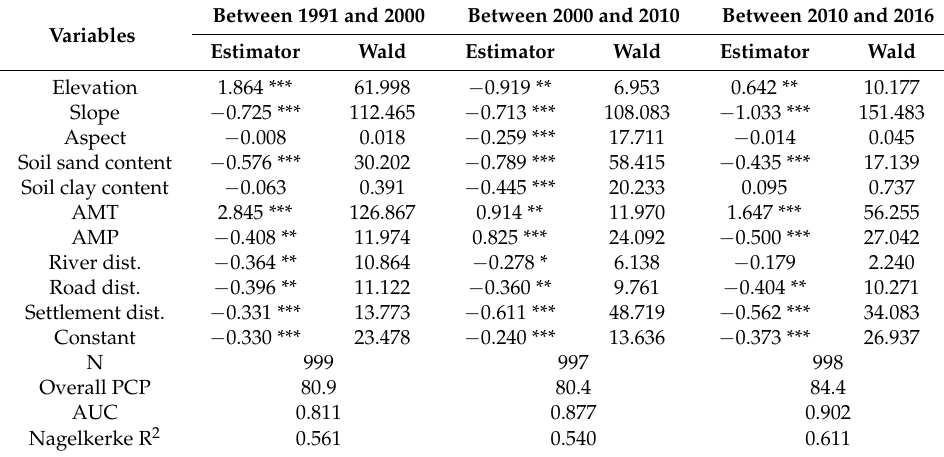
Table 4. Model estimates for farmland expansion driving forces across the Chinese region of the Tumen/Tuman River Basin